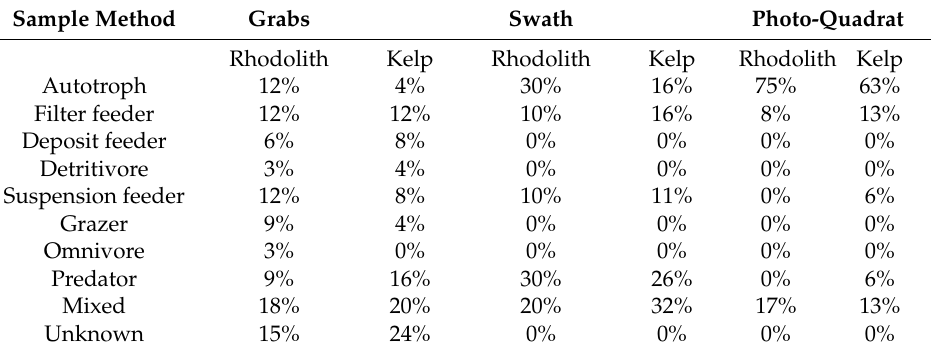
Table 4. The trophic level of each taxonomic unit was identified and the contribution of each functional group to the whole community is expressed as a percentage of all species counted in each survey type in each